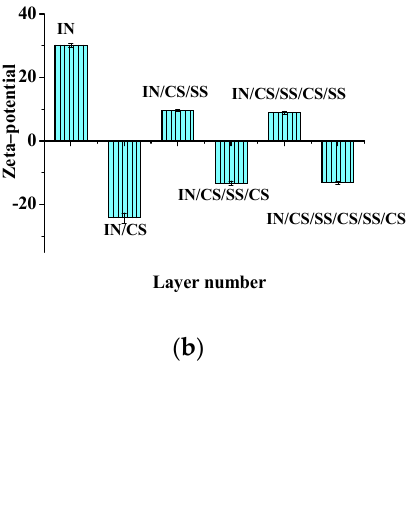
( c ) Figure 1. Zeta − potentials of shell materials ( a ) and multi − layer nanocapsules ( b ), and size of multi − layer nanocapsules ( c ). Abbreviations: IN, insulin; CS, carboxymethyl anionic starch; and SS, spermine cationic starch. Hydration diameters of the insulin and nanocapsules of different layers (single-, triplet-, and quintet-layer) were also evaluated (Figure 1c). The size of the nanocapsules increased from 13 to 42 nm when the layer number increased from single to quintet (Figure 1b), indicating that more modified starch had been deposited on the protein surface by electrostatic interaction, increasing the shell thickness. Thus, the multiple-layer nanocapsules were synthesized using layer-by-layer assembly in this study. 3.2. In Vitro Release Profile Protein-loaded nanocapsules with different layers (single, triplet, and quintet) were treated with SGF, SIF, and SCF to determine the release behavior of the starchy nanocapsules (Figure 2a). The layer number significantly influenced protein release. For example, a single-layer nanocapsule showed the fastest release rate in the upper GIT compared to triplet- and quintet-layer nanocapsules, and around 98% of the IN was released in the stomach. In this case, the protein release rate was too fast in the SGF to reach the colon. For the triplet-layer nanocapsule, there was about 43% IN release in the upper GIT and 57% IN release in the SCF. When the layer increased to quintet, there was the smallest IN release in the upper GIT (36%) and most IN was sustainably released in the lower GIT (64%), presenting a better release property (Figure 2b,c). Therefore, the quintet-layer nanocapsule was more suitable for the release of IN, and the release behavior could be controlled via modifying the layer number.